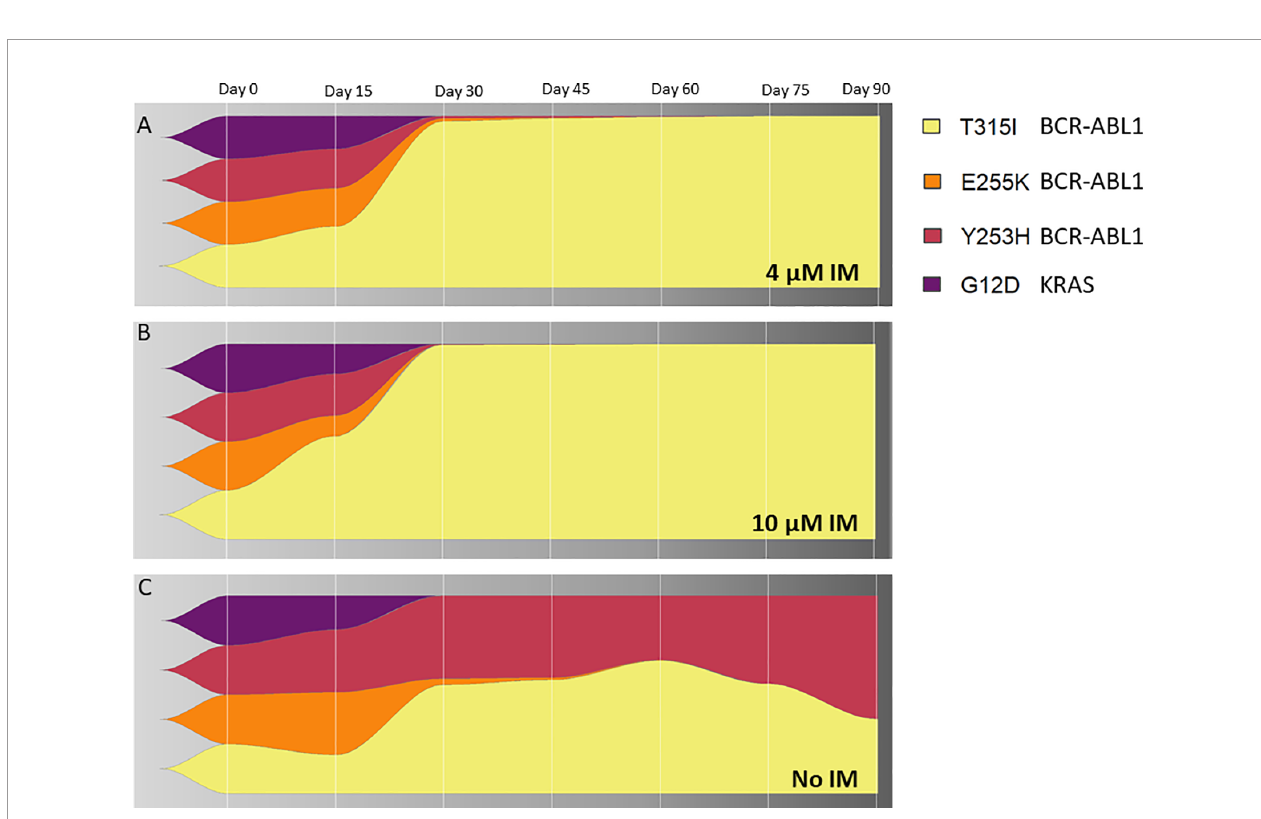
FIGURE 5 | The clonal evolution of KCL-22R resistant clones. Starting from an equal number of cells (1x10 6 ) for each clone (Clone 1, Clone 2, Clone 3 and Clone 4 of KCL-22) growing in 4 µM imatinib, subsequent clonal evolution was followed by the monitoring of mutated BCR-ABL1 transcripts and mutated KRAS at selected time points indicated above the charts. Cells were cultivated for 90 days in stable conditions of (A) 4 µM imatinib, (B) 10 µM imatinib or (C) without imatinib. The superior growing fi tness of Y253H-bearing Clone 2 in imatinib-free conditions is likely due to the presence of additional unmutated BCR-ABL1 fusion in this clone, as revealed by detected copy numbers by ddPCR and con fi rmed by cytogenetic analysis. The presence of BCR-ABL1 KD and KRAS mutations is shown as a percentage of total BCR- ABL1 or KRAS in the cells, respectively, determined by